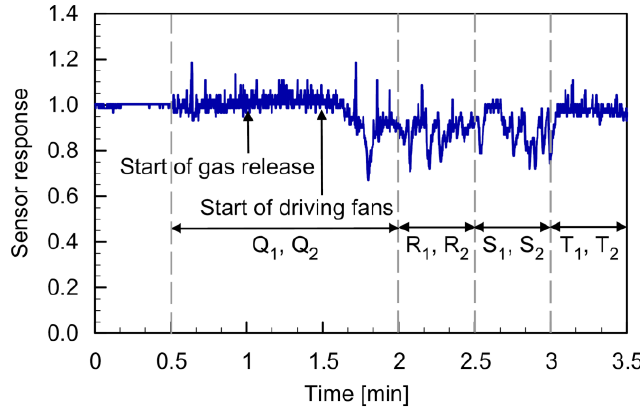
Figure 14. Response curve of the MiCS-5521 sensor during the flight under cross-flow conditions.